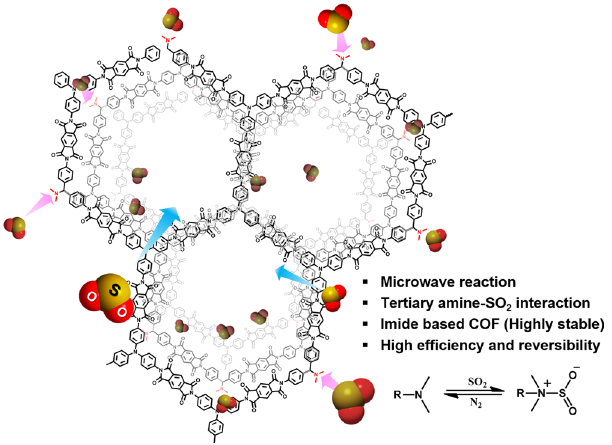
Figure 1. Schematic representation of functionalized PI-COF for SO 2